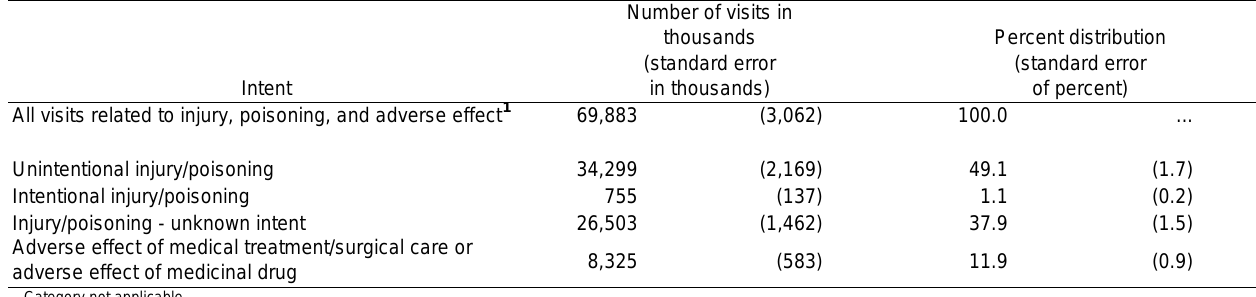
Table 18. Office visits related to injury, poisoning, and adverse effect: United States, 2012